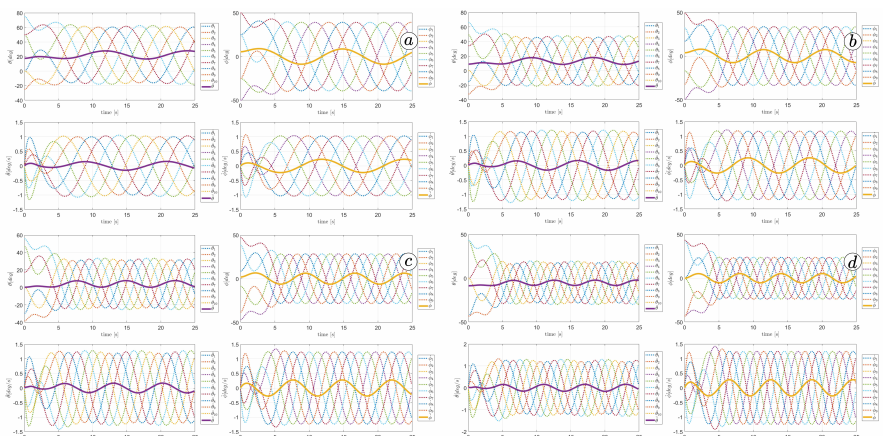
Figure 31. Values of link angles θ , joint angles φ , link angles derivatives ˙ θ , and joint angles derivatives ˙ φ for ω = 30 ◦ ( a ), ω = 40 ◦ ( b ), ω = 50 ◦ ( c ), and ω = 60 ◦ ( d ).